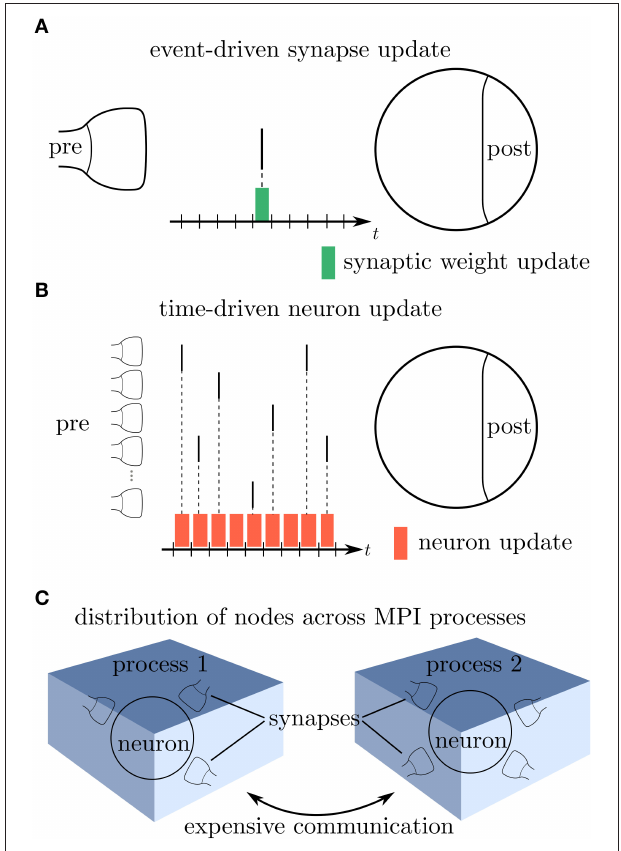
FIGURE 1 | Update schemes for neurons and synapses. (A) A spike crosses a synapse from the presynaptic (pre) to the postsynaptic (post) neuron. Since this is a rare event, the synaptic weight is computed only when a spike is delivered, indicated by the green bar (event-driven update). (B) Neurons with a large in-degree receive spikes in rapid succession which suggests a time-driven update of the neuron’s state in each time step (red bars). (C) Since the computation of the synaptic weights requires information from the postsynaptic neuron, storing the synapses on the same compute node reduces the amount of expensive communication between compute processes.